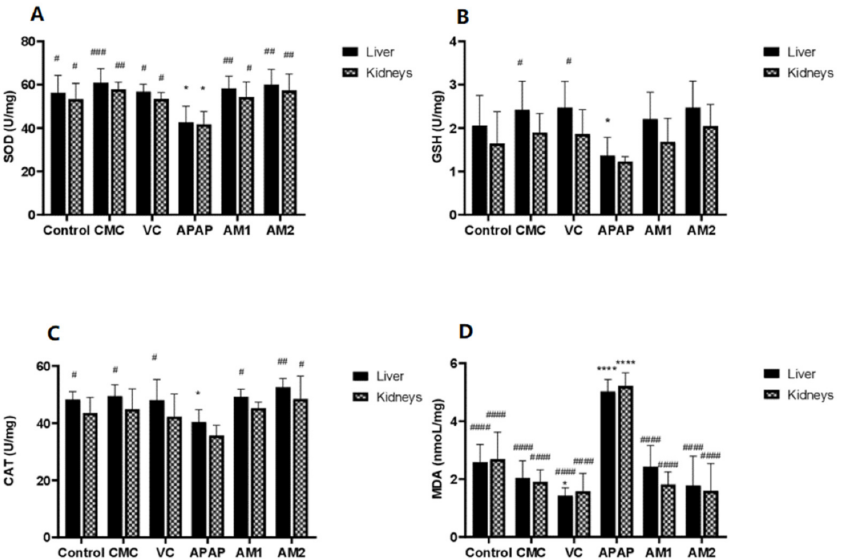
Figure 3. Effect of A. visnaga L. essential oil on antioxidant enzymes and MDA levels against acetaminophen-induced liver and kidneys injury in mice. Values are expressed as the mean ± SD ( n = 5), * p < 0.05; **** p < 0.0001 vs. the normal control group and # p < 0.05; ## p < 0.01; ### p < 0.001; #### p < 0.0001 vs. the toxic control group. ( A ) Effect of A. visnaga L. on the SOD level in APAP-treated mice liver and kidneys; ( B ) Effect of A. visnaga L. on the GSH level in APAP-treated mice liver and kidneys; ( C ) Effect of A. visnaga L. on the CAT level in APAP-treated mice liver and kidneys; ( D ) Effect of A. visnaga L. on the MDA level in APAP-treated mice liver and kidneys. SOD: superoxide dismutase; GSH: reduced glutathione; CAT: catalase; MDA: malondialdehyde; AA: ascorbic